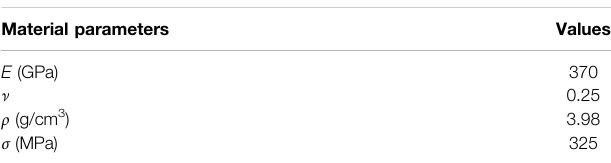
TABLE 1 | Material parameters of Al 2 O 3